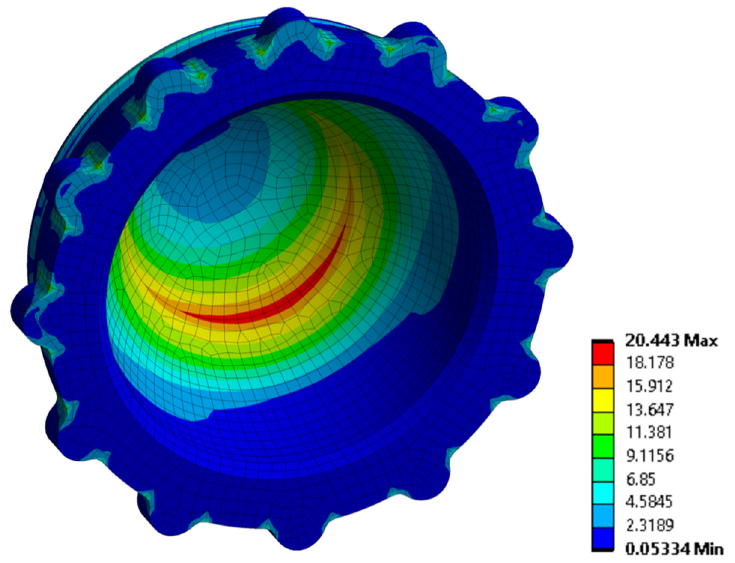
Figure 5. Von Mises stress distribution as a wear risk (MPa) criterion for the polyethylene liner in uncemented fixation.